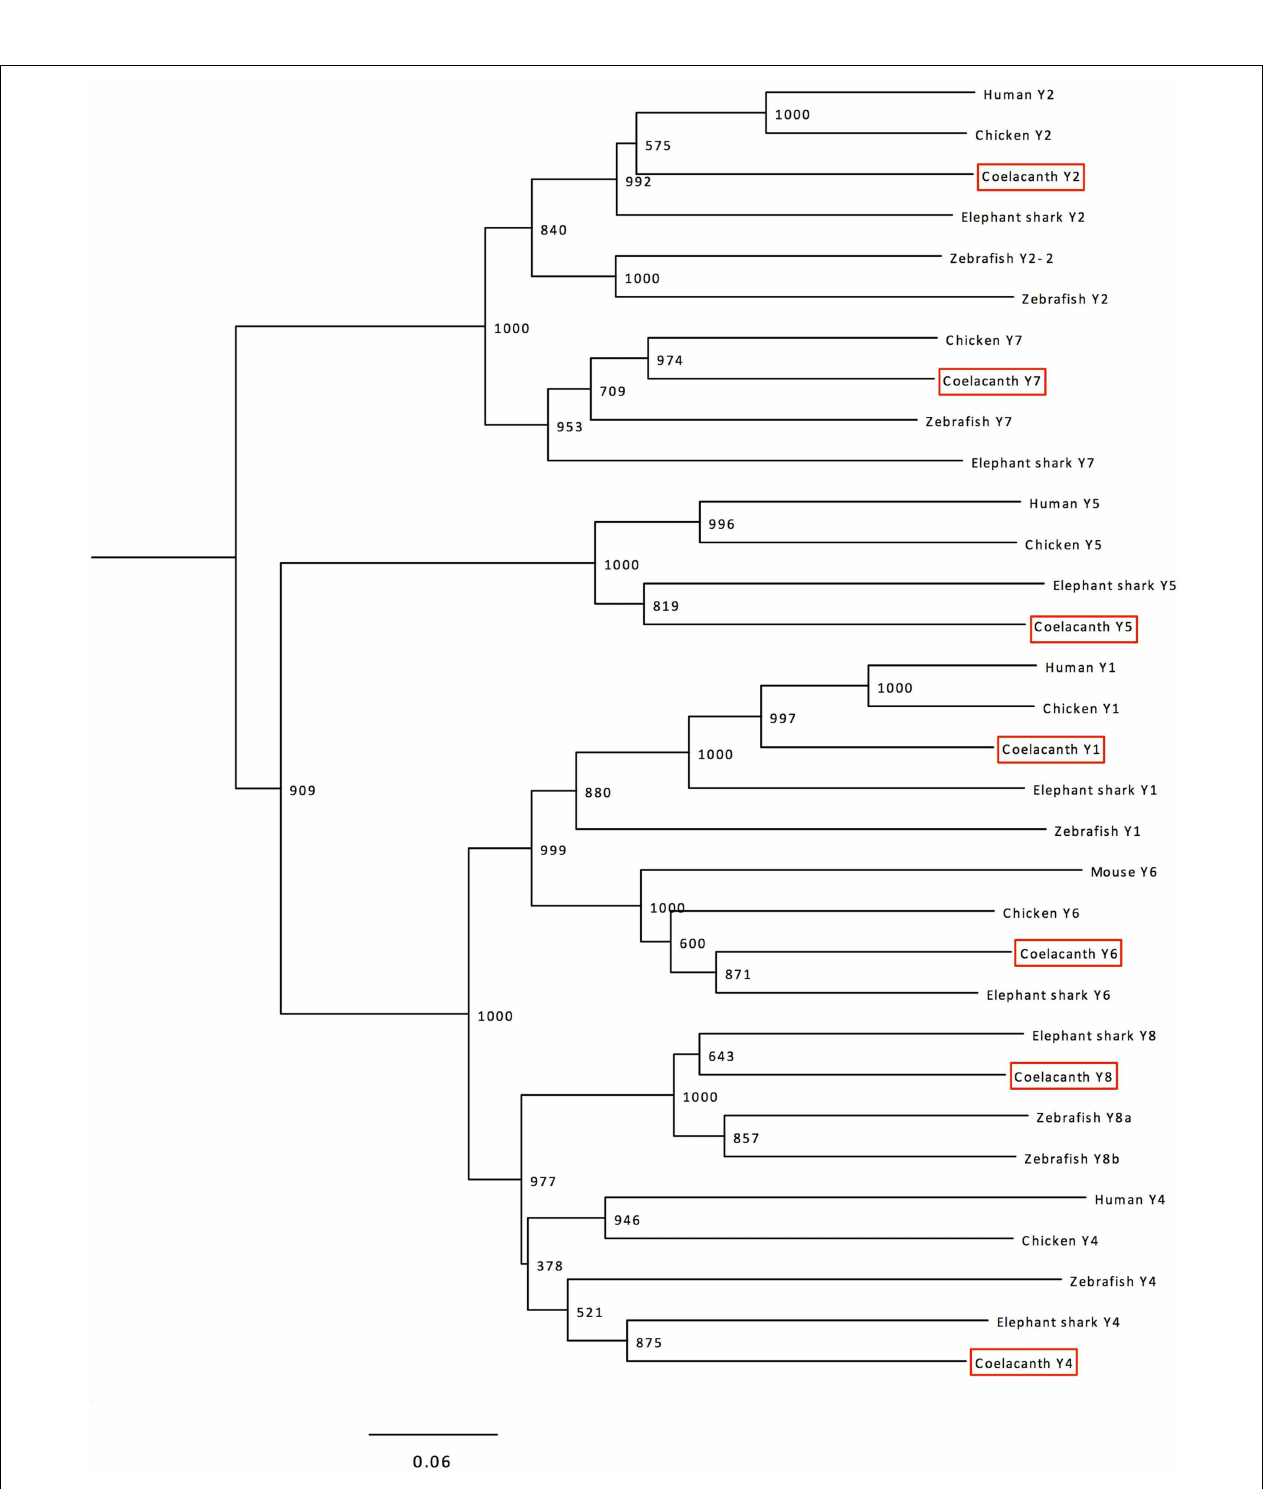
root the tree.The tree was calculated using the complete sequences aligned with ClustalW.Trees were also deduced using the Maximum Likelihood method and both methods were also used to calculate trees based on an alignment generated with MUSCLE.These trees are available from the authors upon request. See text for